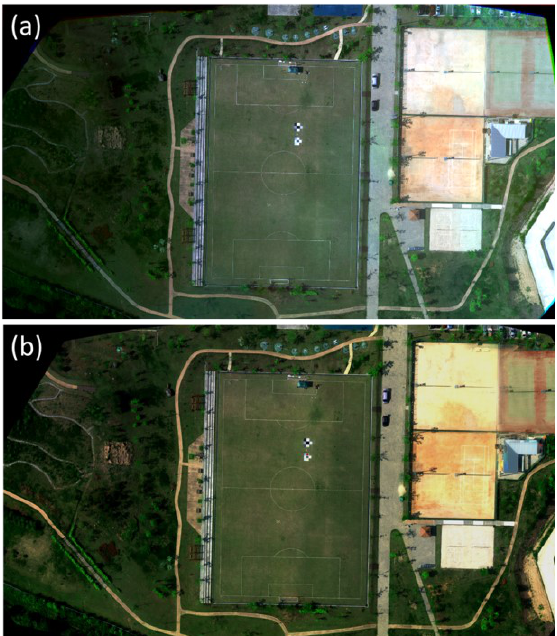
Figure 7. Selection of optimal images using number of tie points between image pair that was selected by weight and number of tie points 3.4 Relative Radiometric Calibration